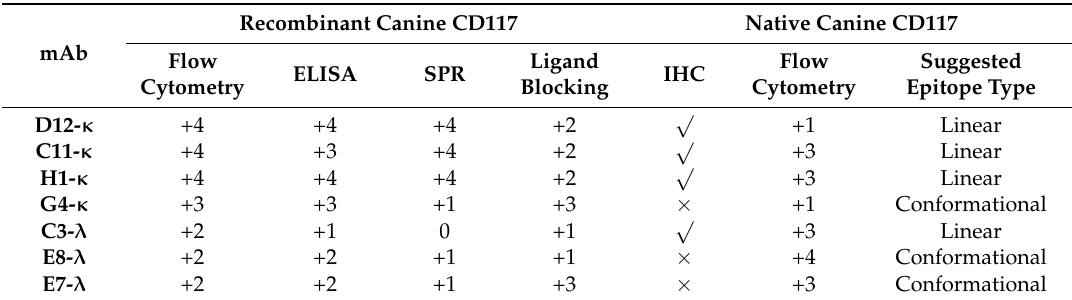
Table 3. Summary of anti-canine CD117 mAb characterizations on recombinant versus native canine CD117. Here, 0–4 describes the strength of mAb–CD117 interactions in an ascending order from none (“0”) to very strong (“4”). IHC: Immunohistochemistry. Recombinant Canine CD117 Native Canine mAb